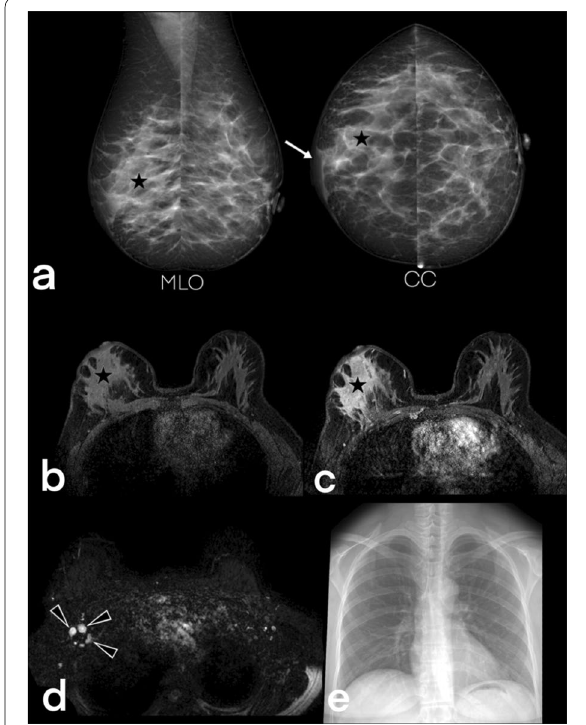
Fig. 4 Mammograms of a 44-year-old female demonstrate disseminated tuberculosis in right breast ( a ) show an asymmetric opacity (star) and thickening of the skin (arrow). MRI images of the same patient: pre-contrast fat-suppressed T1-weighted ( b ), post-contrast fat-suppressedT1-weighted ( c ), and fat-suppressed T2-weighted images ( d ) show homogeneous non-mass enhancement with regional type distribution (star) and axillary lymph nodes (arrowheads). The chest x-ray ( e ) of the patient is negative